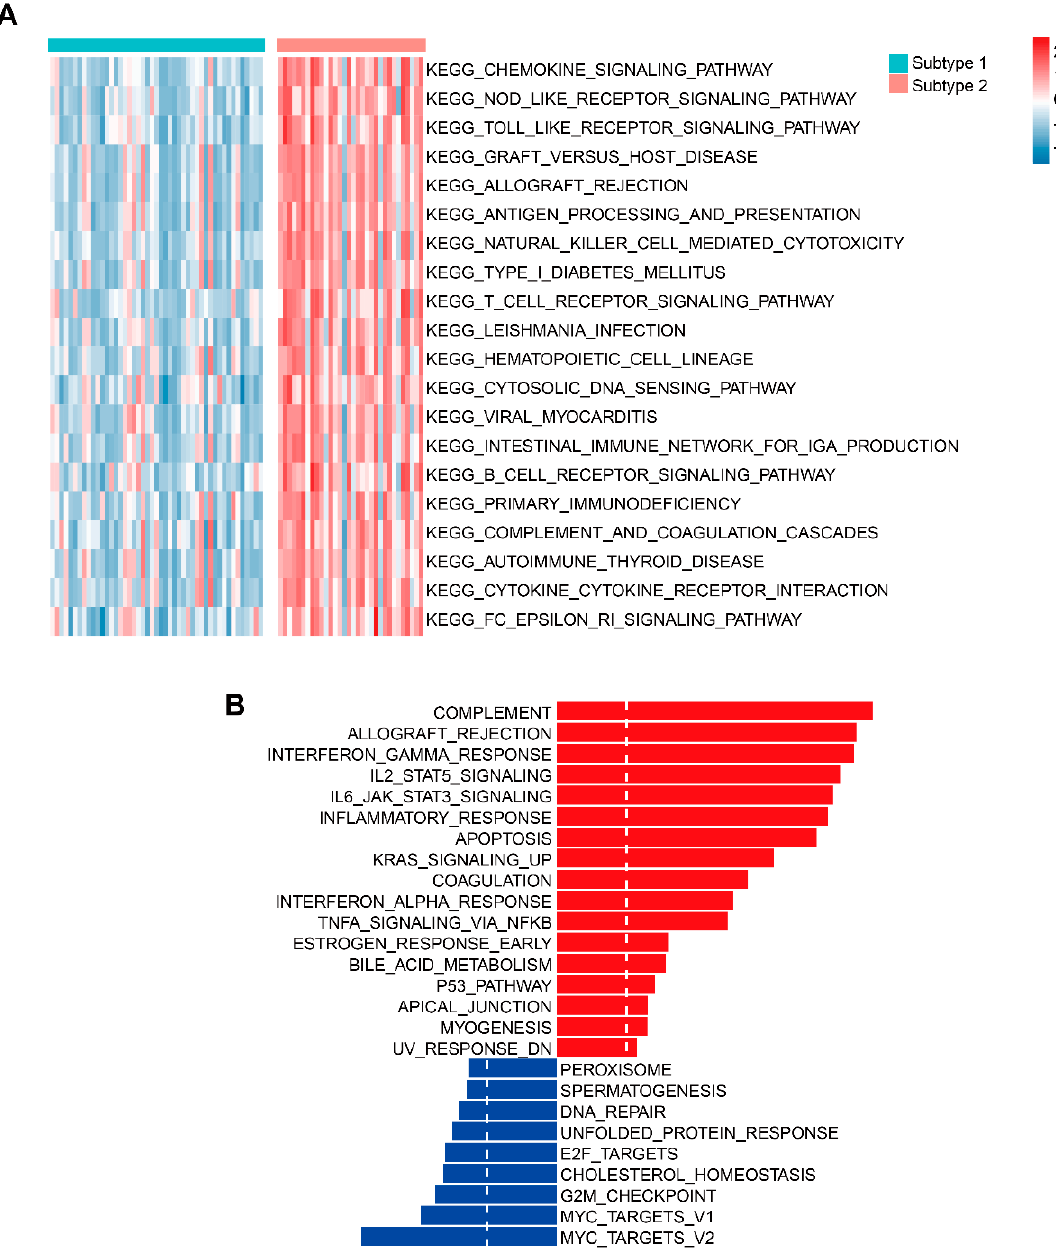
Figure 6. GSVA analysis of KEGG and Hallmark pathways for TME-related subtypes. ( A ) Heatmap showing the top 20 most significant KEGG pathways between subtypes 1 and 2. ( B ) Distribution of significant Hallmark pathways between subtypes 1 and 2.The red item represented the most relevant pathways to subtype 2. The blue item represented the most relevant pathways to subtype